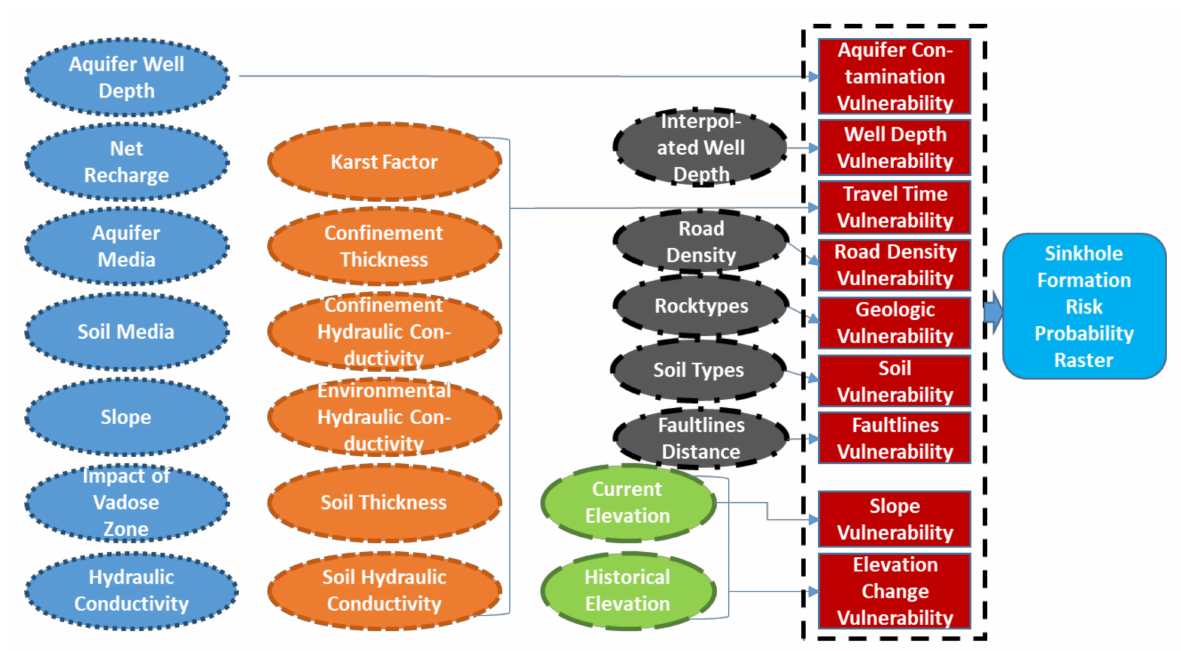
Figure 5. Geospatial modeling framework for determining sinkhole formation